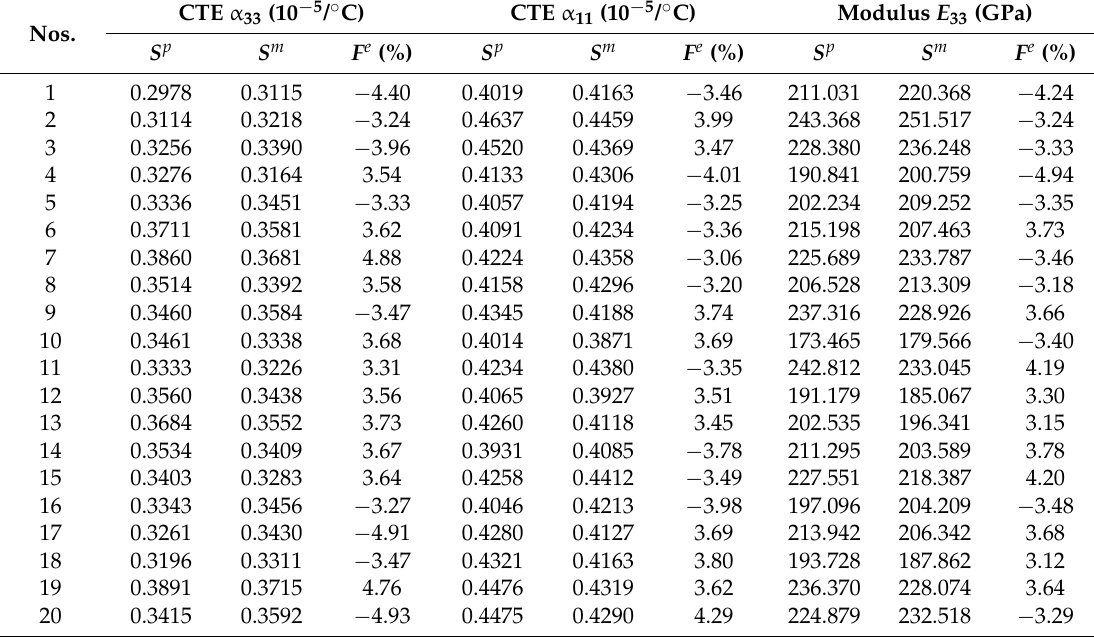
Table 5. Comparison between the neural network prediction and micromechanical